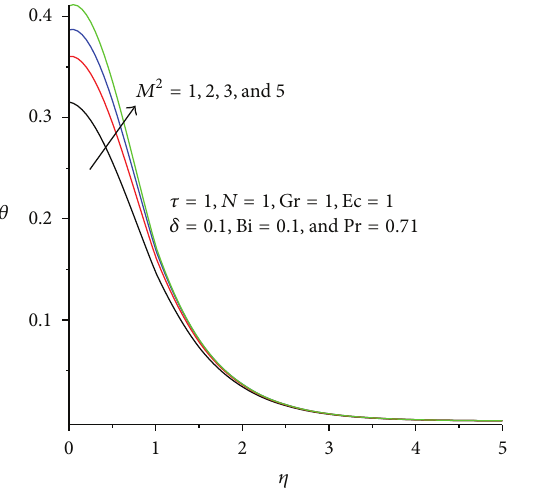
Figure 15: Temperature profiles with increasing Ec.